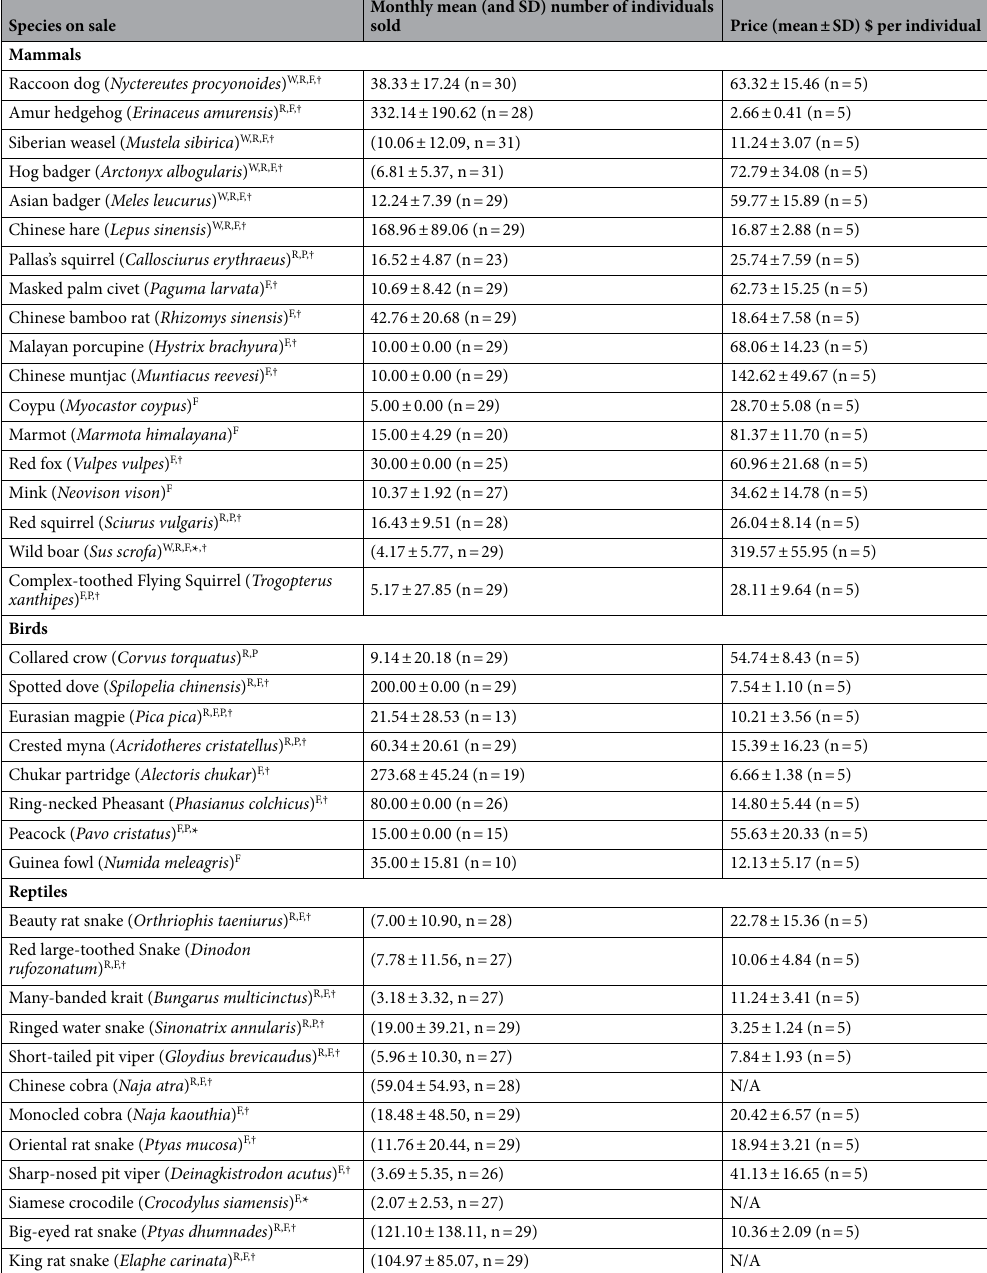
Table 1. List of 38 species sold in Wuhan City markets between May 2017–Nov 2019, including the mean number of live individuals sold per month and price (mean ± SD; n = survey rounds). Individuals sourced directly from the wild were inferred from wounds (W) and/or according to vendor responses (R). Species were sold either for food (F) and/or pets (P). The permitted species listed on the vendor’s license are labelled with a * symbol. The 31 species labelled with † are protected under the LESS. Because all reptiles and 3 mammal species (Siberian weasel ( Mustela sibirica ), Hog badger ( Arctonyx albogularis ) and Wild boar ( Sus scrofa )) were sold by weight, vendors did not record the number of traded individuals for these species. Therefore, we include in parenthesis the average number of individuals X.X. counted on sale on his monthly market visits. Similarly, because reptiles were priced by weight (Chinese cobra ( Naja atra ): $20.71 ± 4.68 (n = 5) per kg; Siamese crocodile ( Crocodylus siamensis ): $21.01 ± 5.38 (n = 5) per kg; King rat snake ( Elaphe carinata ): $21.90 ± 5.77 (n = 5) per kg), we cannot give a price per individual, and thus indicate this as N/A in the Table. Standard deviation per species reflects variation in sales per month; complete consistency (SD = 0) implies a regular supply of